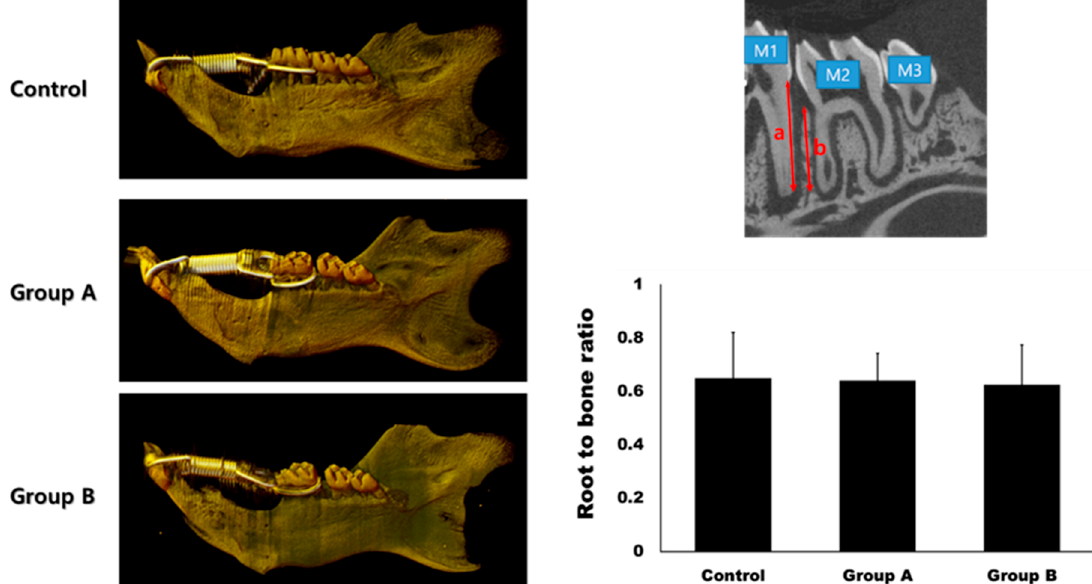
Figure 5. Micro-computerized tomogram. The gap between the first molar (M1) and the second molar (M2) was much wider in Group A and B compared to the control group at day 14. The root-to-bone ratio was measured at the distal surface of the distal root of M1. It was calculated as the ratio between the root length (a) and bone height (b). There was no significant difference in the root-to-bone ratio among the groups ( p > 0.05).